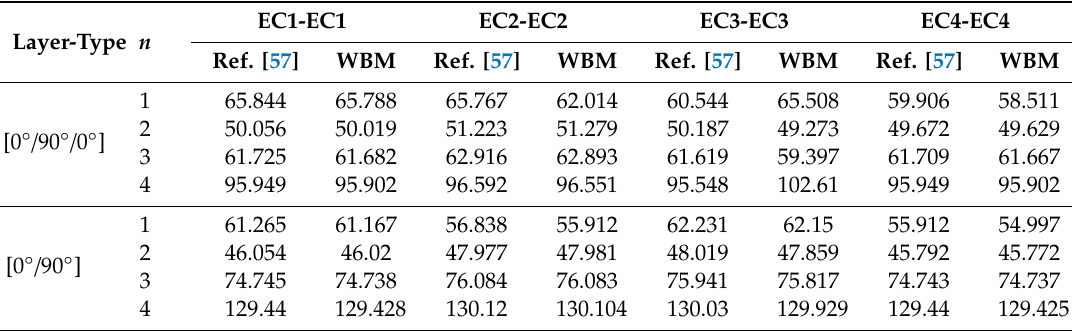
(cid:112) ρ Table 7. Frequency parameters Ω = ω L 2 / E 2 / h for two types of cross-ply composite laminated cylindrical shells with elastic boundary conditions ( L / R = 4, h / R = 0.1, E 2 = 2 GPa, E 1 / E 2 = 25, µ 12 = 0.25,